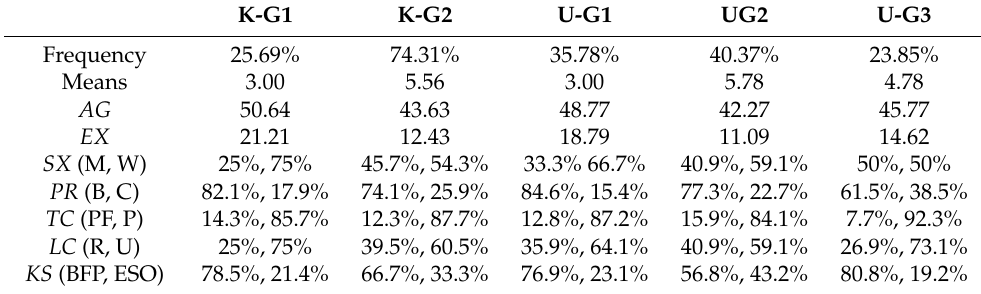
Table 10. Cluster groups as regards the knowledge and use of communication tools